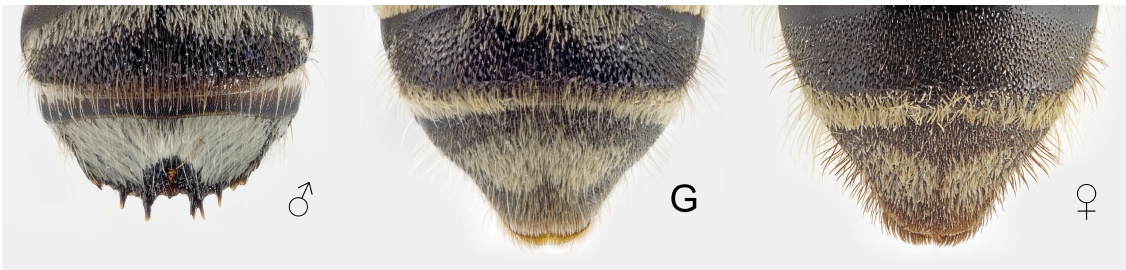
Figure 6. Last tergite of Megachile pilidens , dorsal view: Hind metatarsi : Simple and with long white hairs (dilated and with dense yellow pubescence in females) (Figure 6).